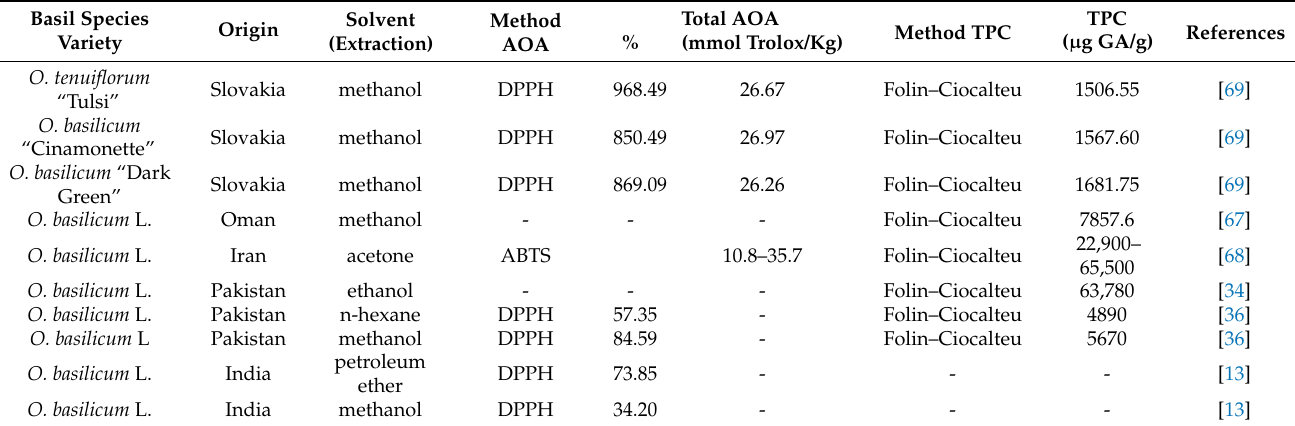
GA: Gallic acid, standard unit for phenolic content determination. The results are expressed in dry weight. AOA: Antioxidant Capacity Analysis. TPC: Total Phenolic Content. DPPH: (2,2-diphenyl-1-picryl-hydrazyl-hydrate) ABTS: 2 2’-azino-bis(3-ethylbenzothiazoline-6- sulfonic